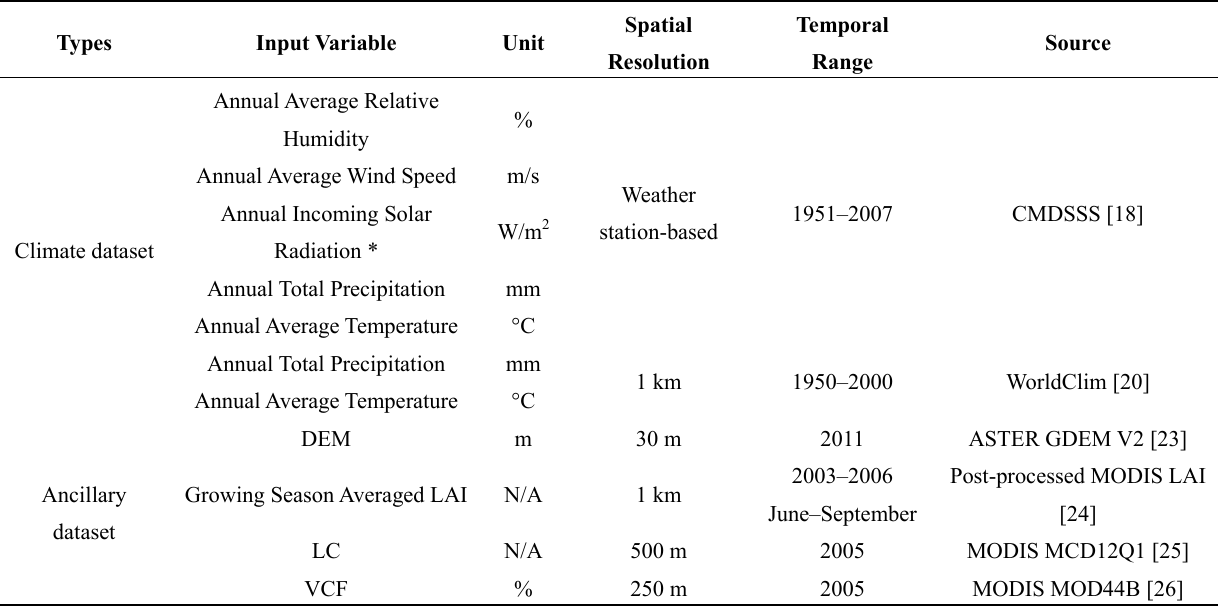
Table 1. Climatic and ancillary datasets prepared for the Allometric Scaling and Resource Limitation (ASRL)